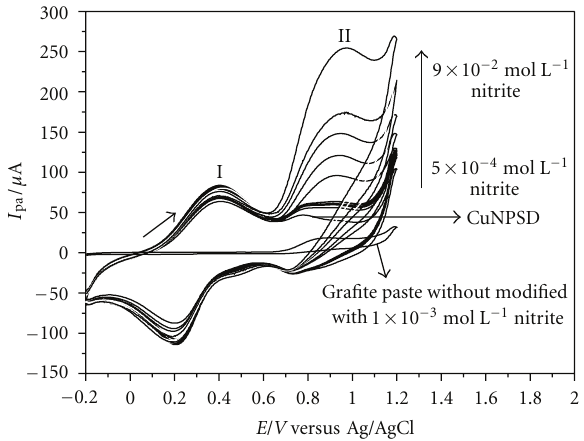
Figure 9: Analytical curve of the anodic peak (II) for the determina- tion of nitrite using a CuNPSD-modified graphite paste electrode (KCl = 1.0 molL − 1 ; pH = 7.0; v = 20mVs − 1 ). the process [42, 43] at the interface of electrolyte solution is given by